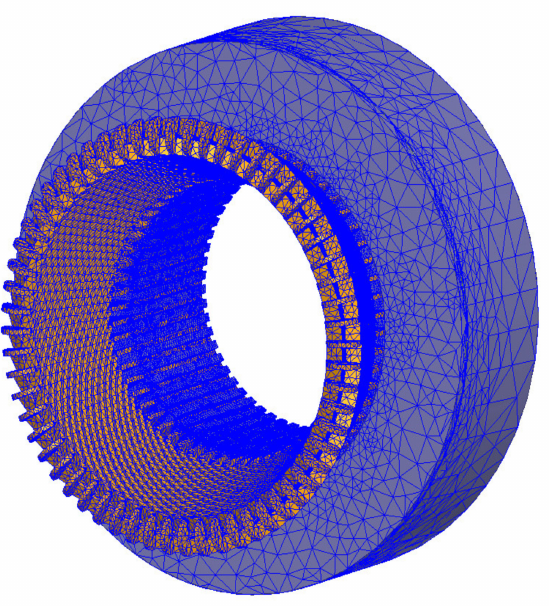
Figure 2. Fragment of the finite element